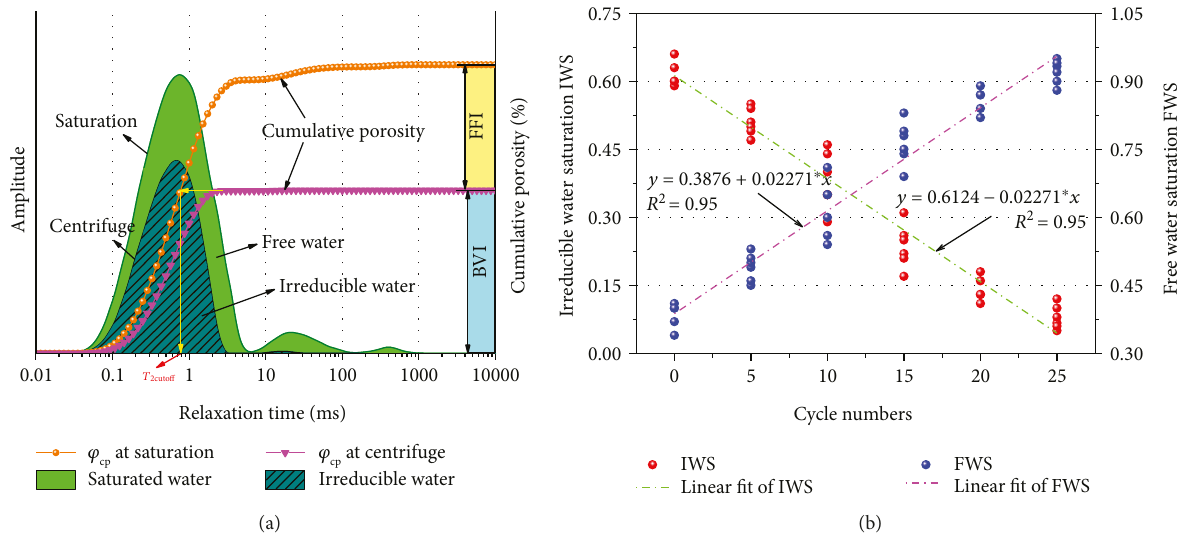
Figure 8: Diagram of the porosity division dependent on the T